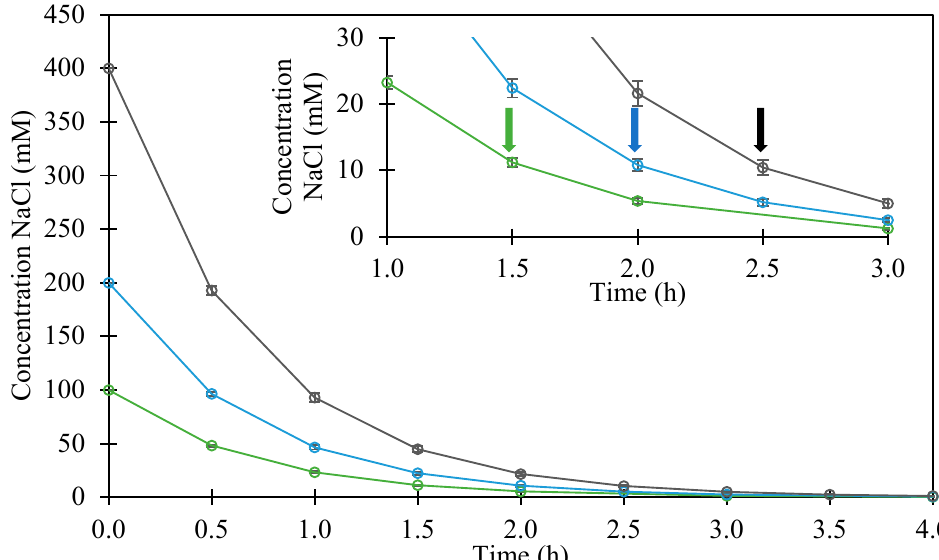
Figure 4. Evolution of ionic strength inside the dialysis tube as monitored by conductivity during 4 h of dialysis of lactoferrin– β -lactoglobulin mixed at various initial ionic strength: 100 mM ( green ), 200 mM ( blue ) and 400 mM ( black ). Insert: zoom on the three first hours. Arrows indicate the time of the maximum of turbidity for each experiment. Dialysis experiments were conducted against 10 mM MES buffer at pH 5.5.